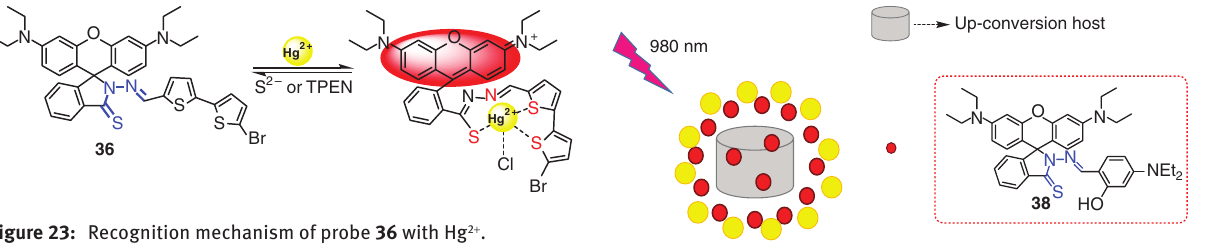
O @MCM-41@R6. 3 4